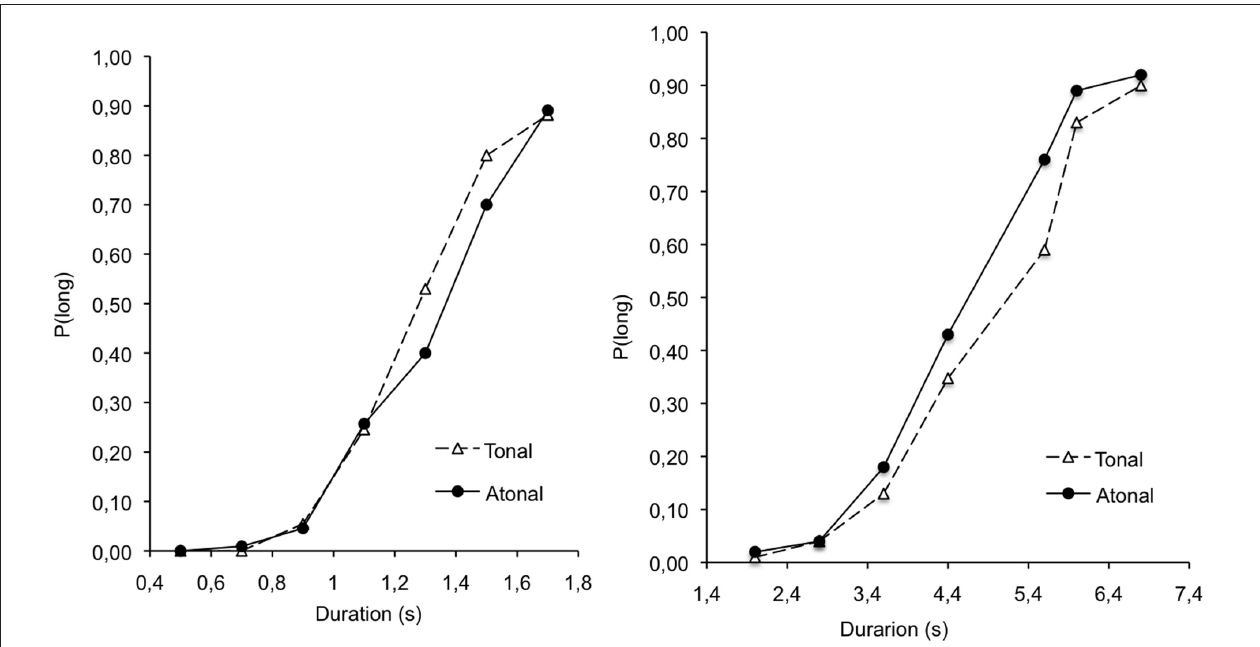
FIGURE 3 | Proportion of long responses plotted against stimulus duration for the tonal and atonal music in the 0.5–1.7 and the 2.0–6.8s duration conditions.